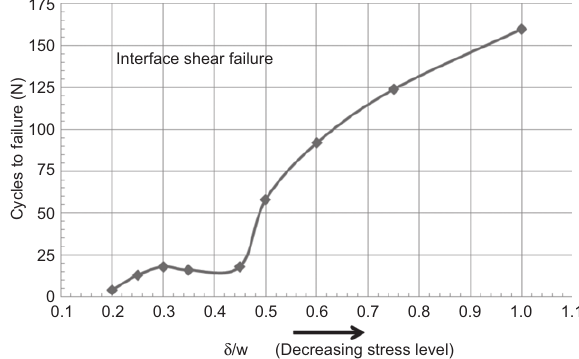
Figure 6 Average number of cycles to failure as a function of flaw size for Type 1 specimens. No shift in modes of failure.